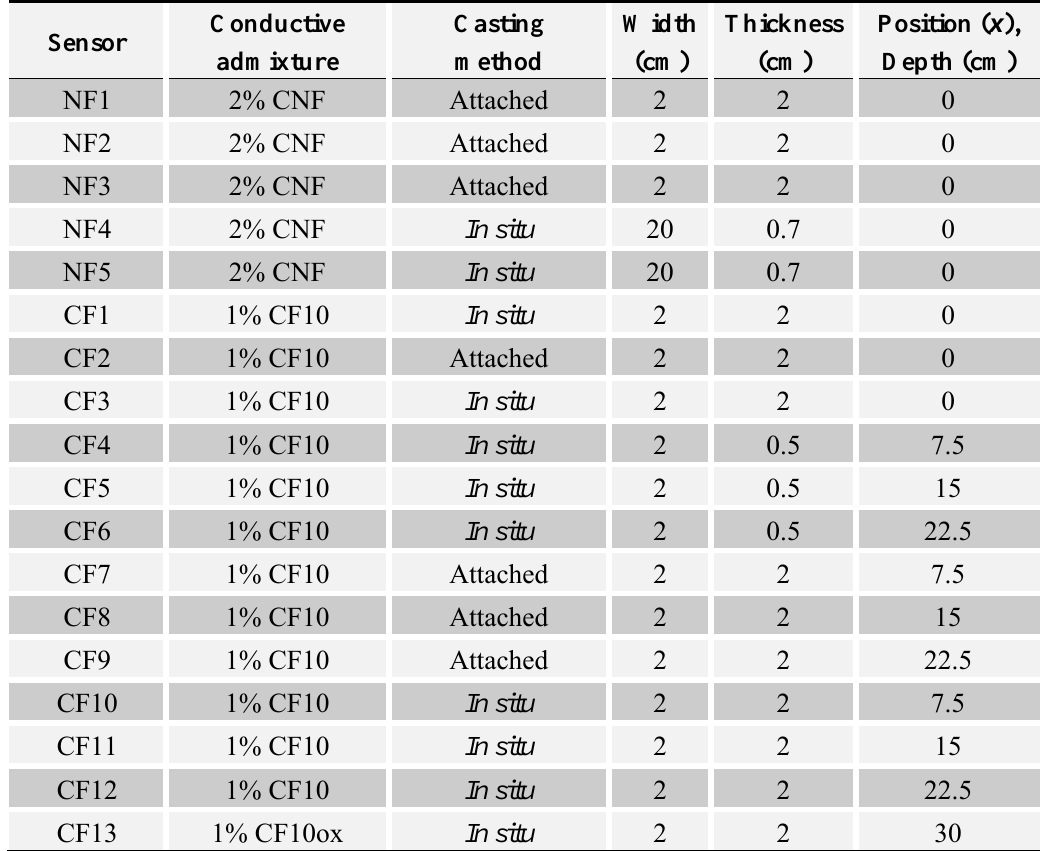
Table 3. Sensors properties (dimensions, casting method, location and electrical